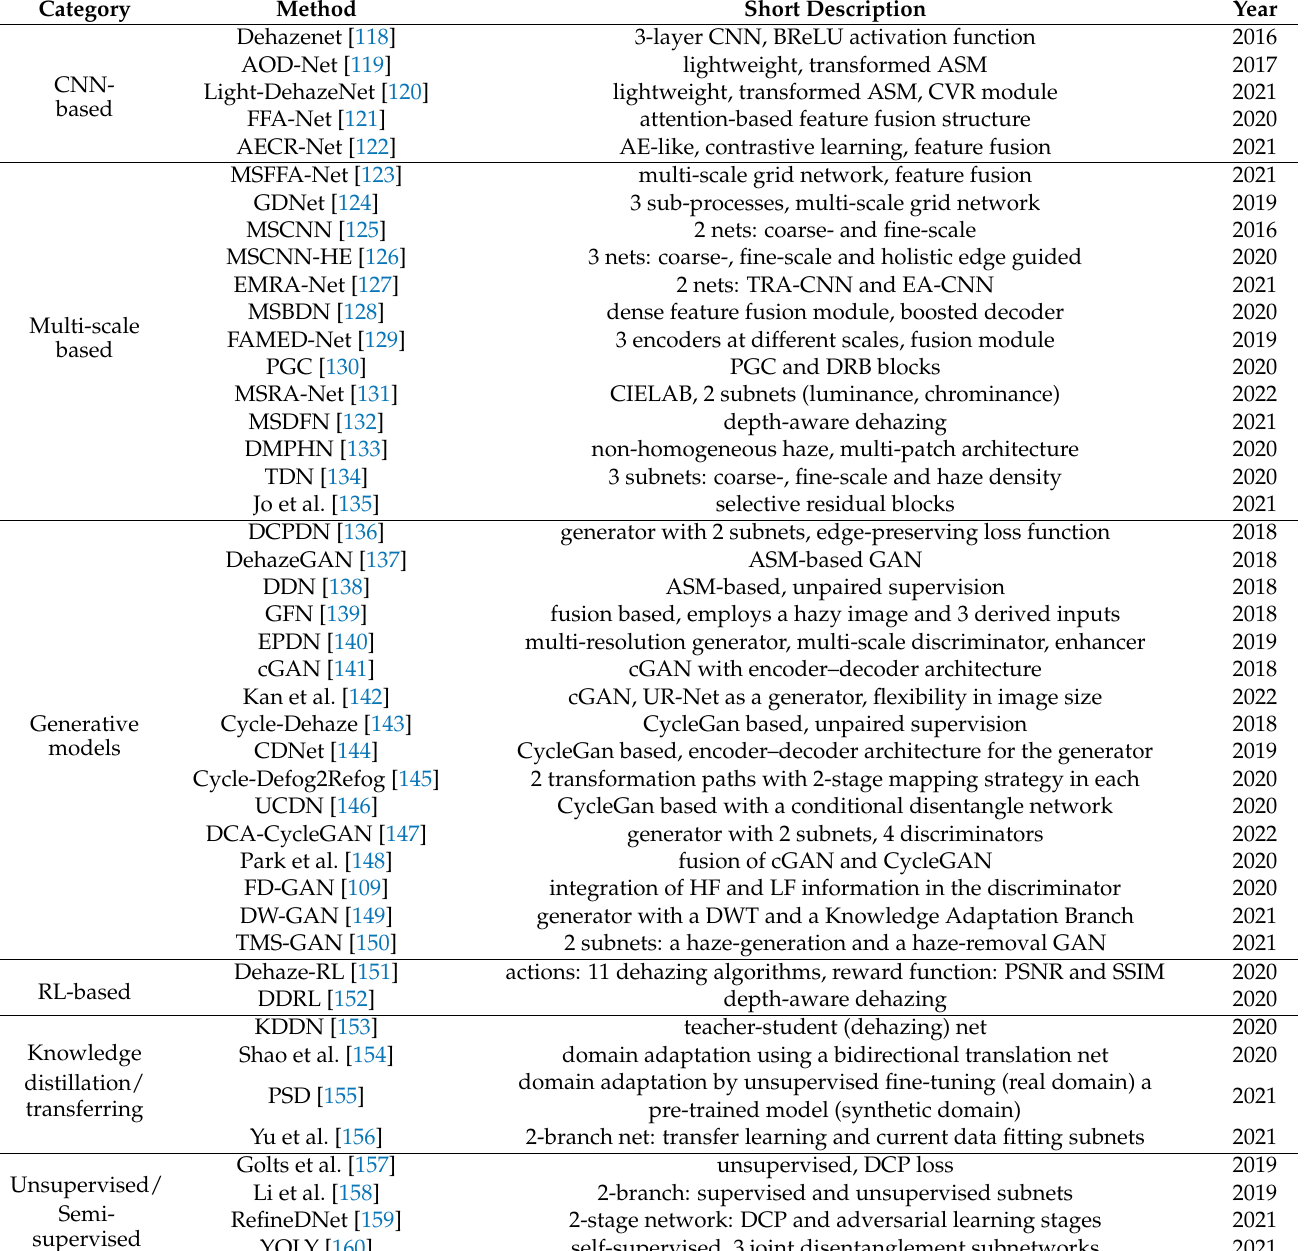
Table 6. Listing of the surveyed research papers and articles on the dehazing